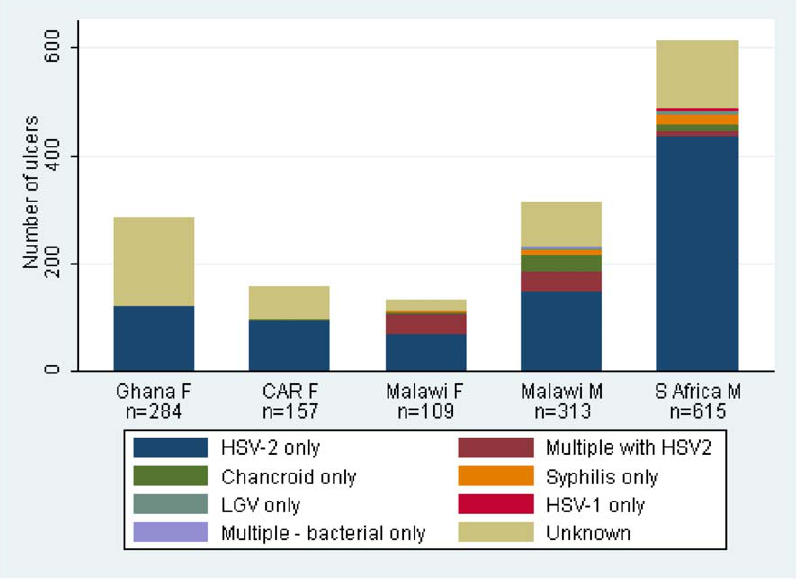
Figure 2. Ulcer aetiology in genital ulcer disease patients in Sub-Saharan African trials, by country and sex. doi:10.1371/journal.pone.0022601.g002 PLoS ONE |